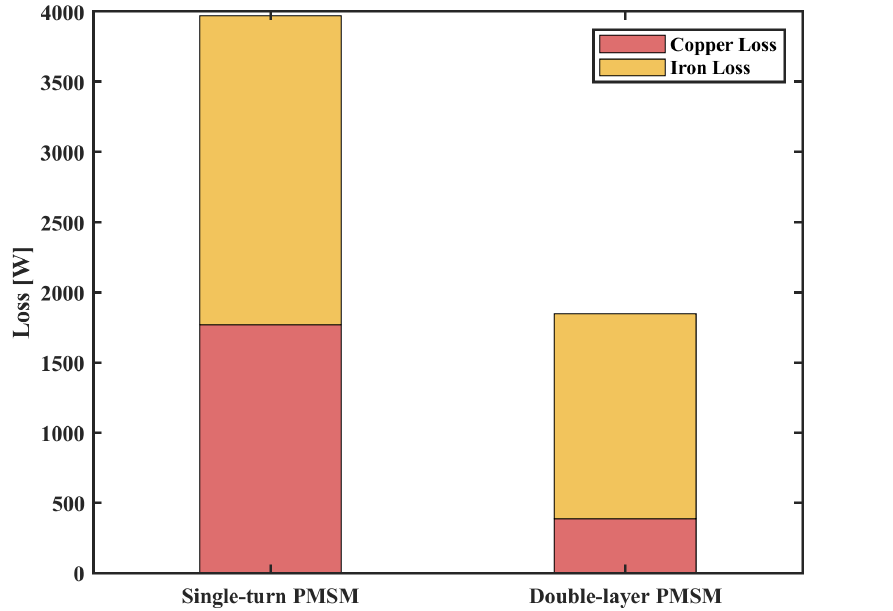
Figure 15. Losses for single-turn winding structure and conventional winding structure under load